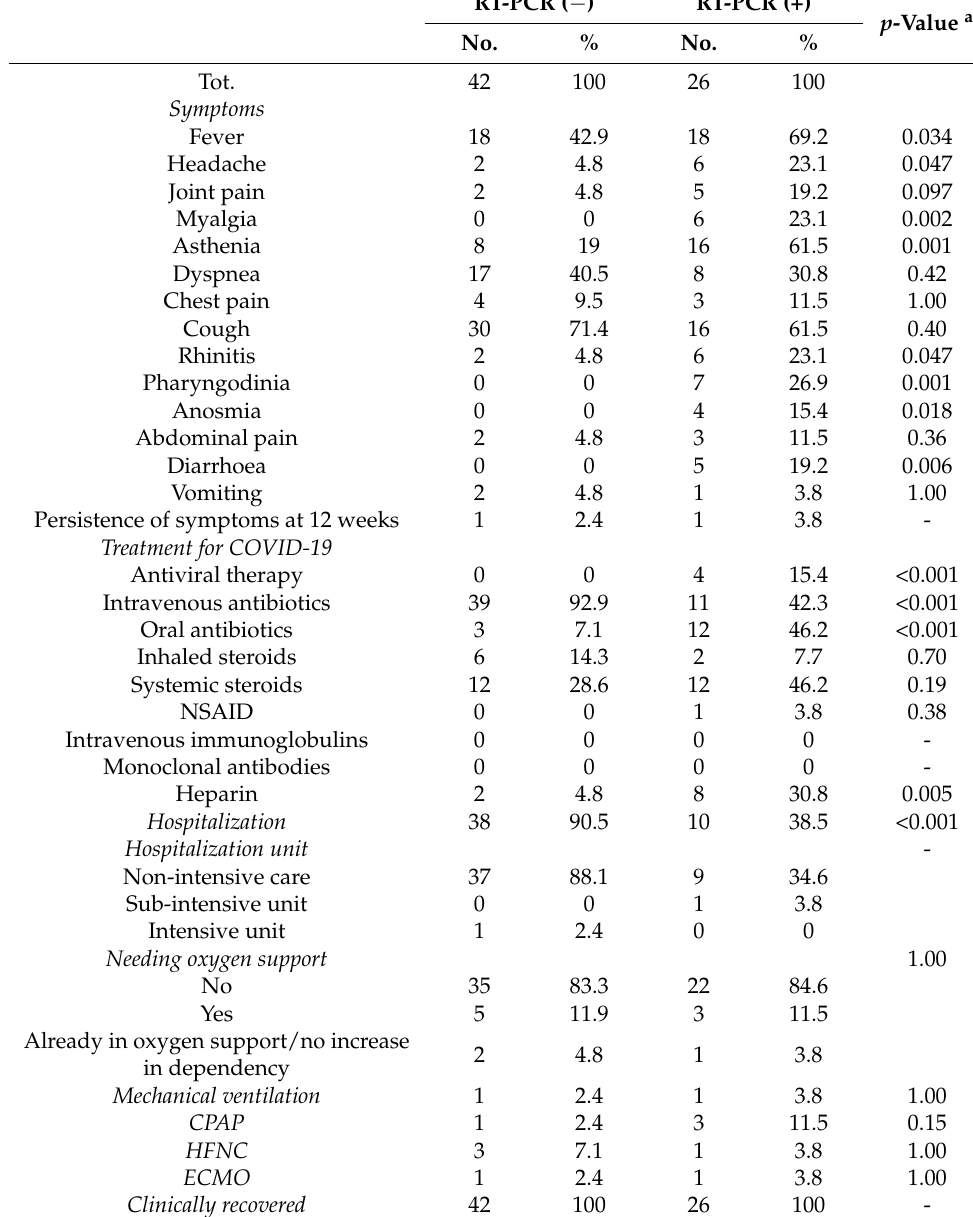
Table 2. COVID-19-related symptoms, treatment, and severity according to SARS-CoV-2 infection status. RT-PCR ( −